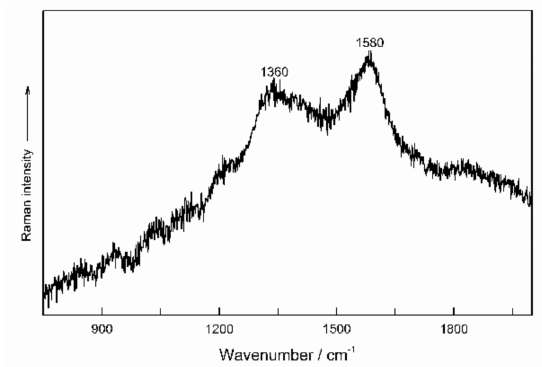
Figure 8. Sample My44: Raman spectra of carbon